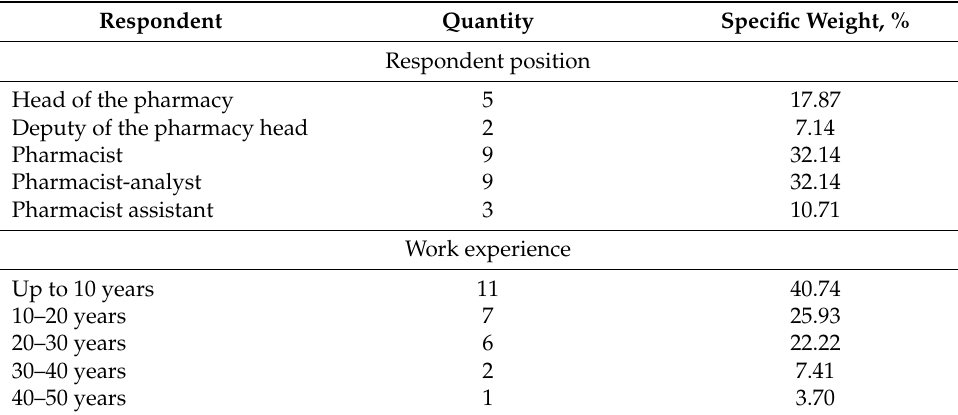
Table 1. Characteristics of respondents who participated in the survey.